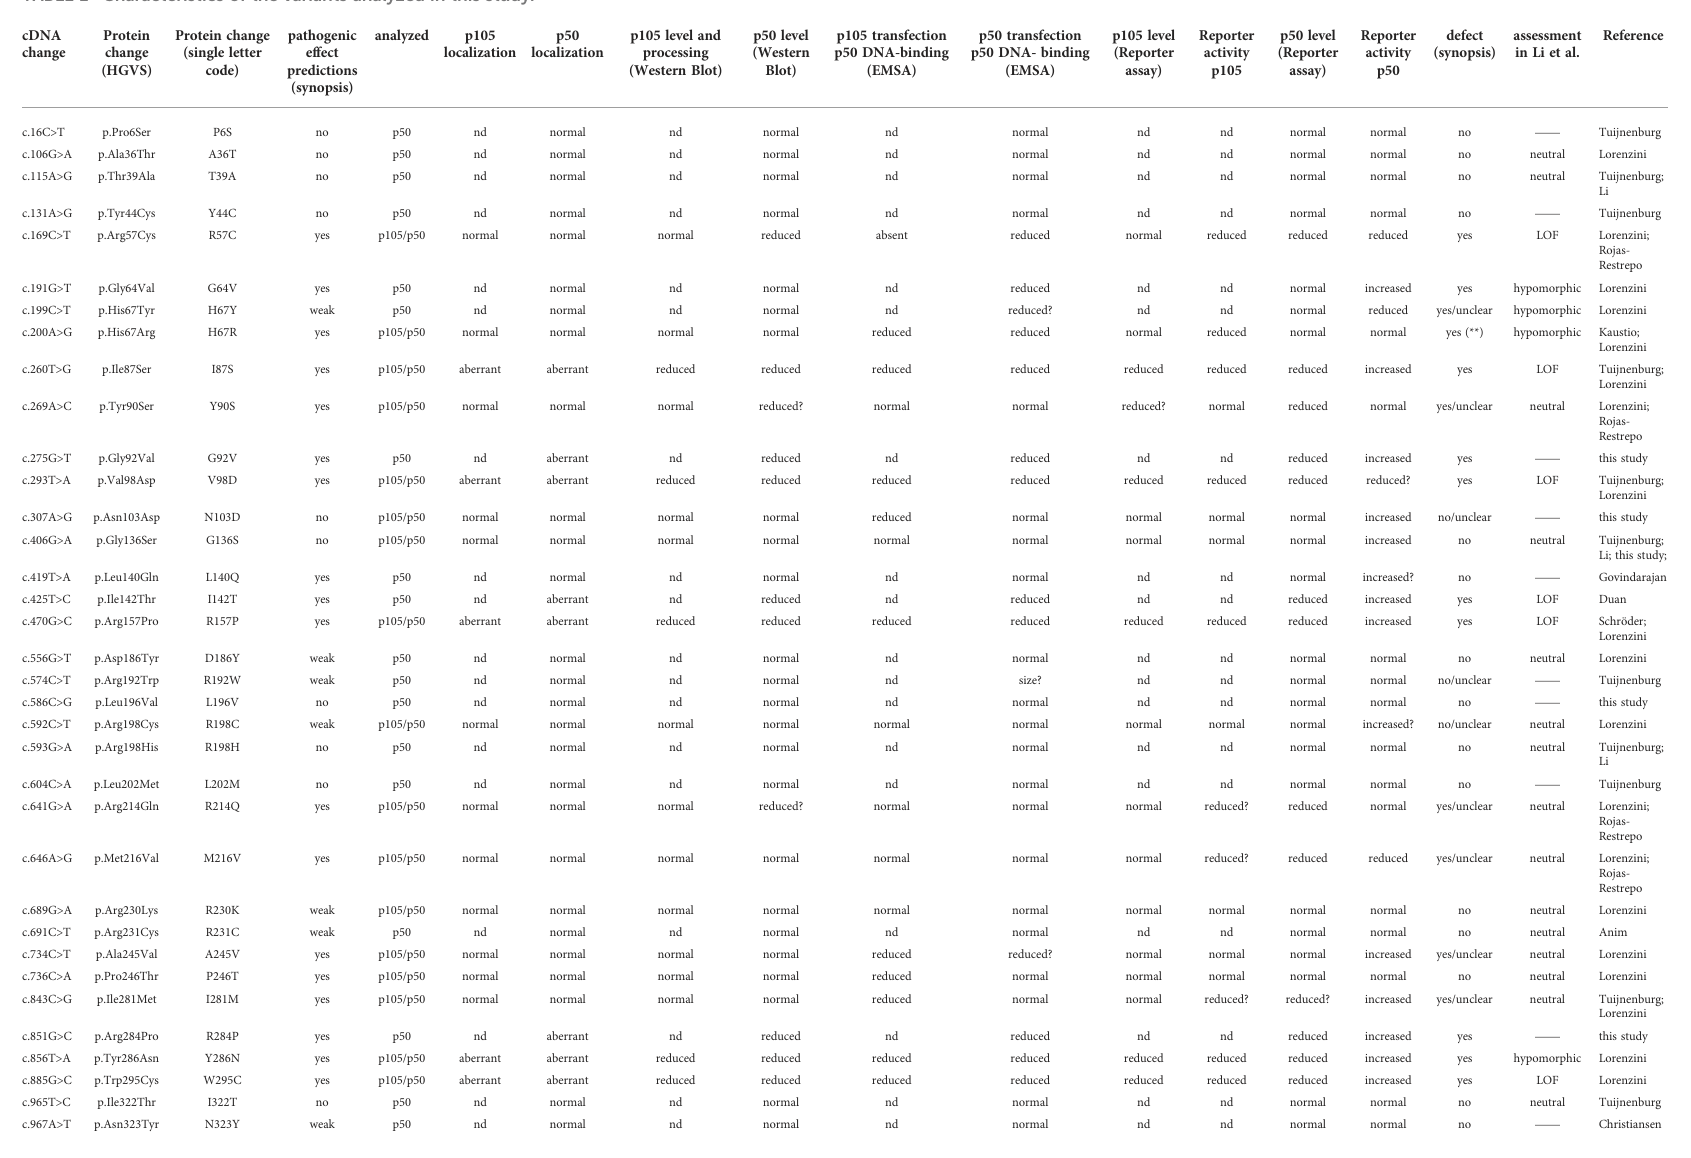
TABLE 1 Characteristics of the variants analyzed in this